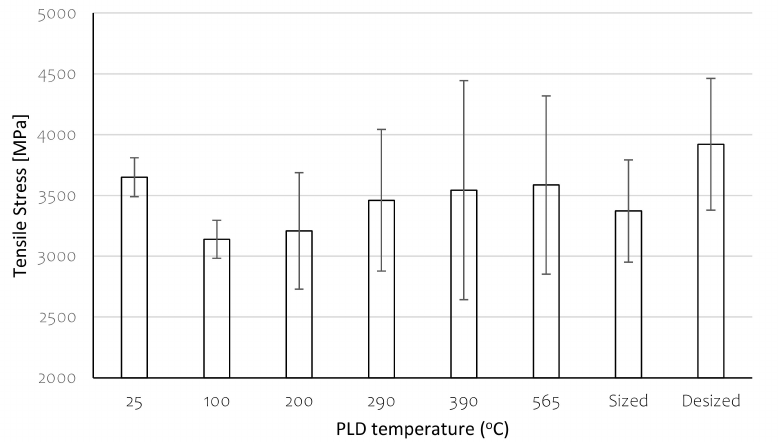
Figure 15. Tensile strength of PLD-treated fibres. Values for sized (commercial) and desized fibres are shown for